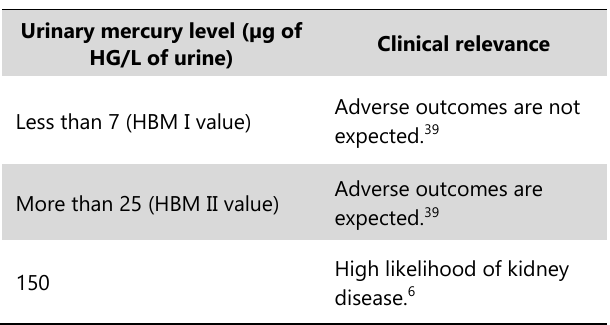
Clinical relevance